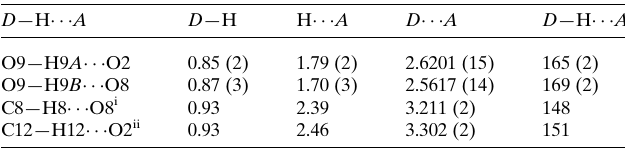
Table 2 Hydrogen-bond geometry (A˚ , (cid:5) ) for 2